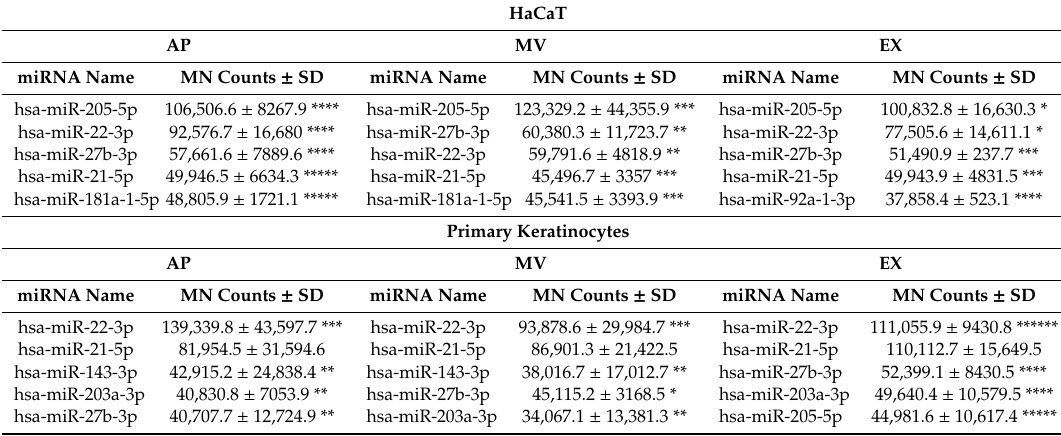
keratinocyte-derived